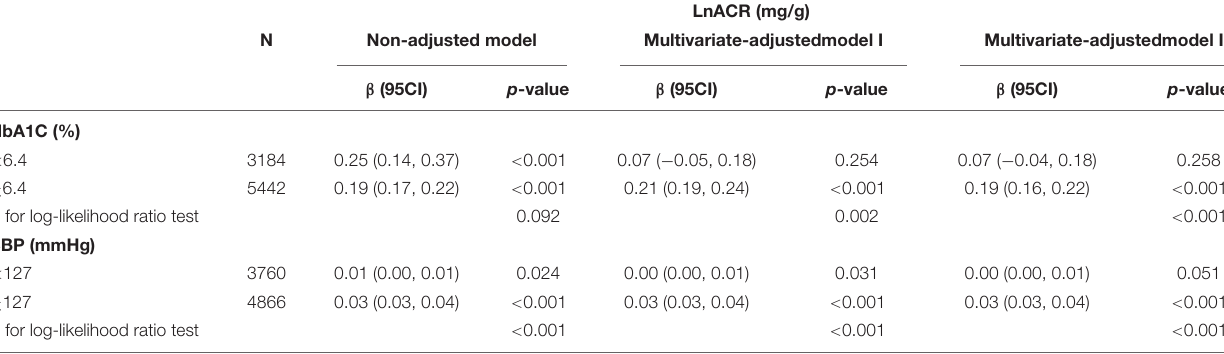
TABLE 3 | Threshold effect analysis of HbA1c or SBP on ACR using two-piecewise linear regression.